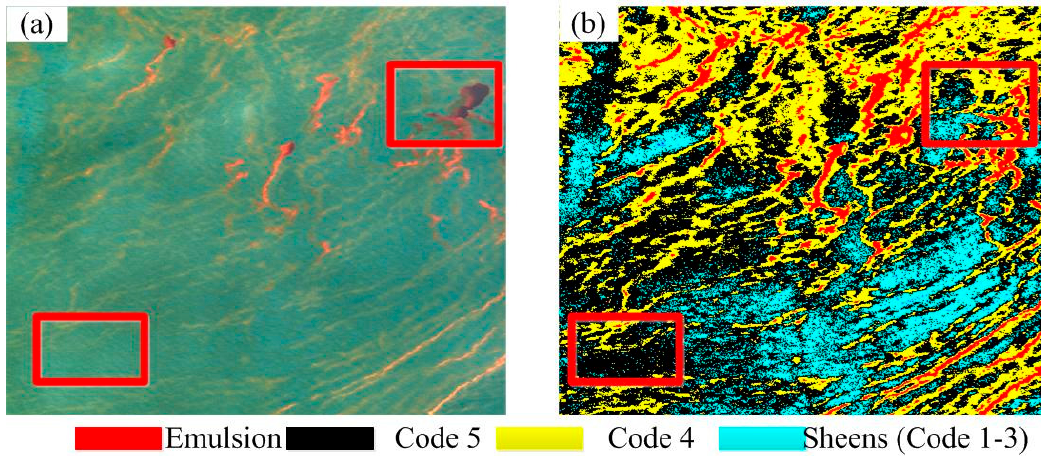
Figure 12. Photo ( a ) is the original training image, and image; ( b ) is the identification result: red pixels represent identified emulsions, black pixels are oil slicks of code 5, yellow pixels are oil slicks of code 4, and cyan pixels are sheens.